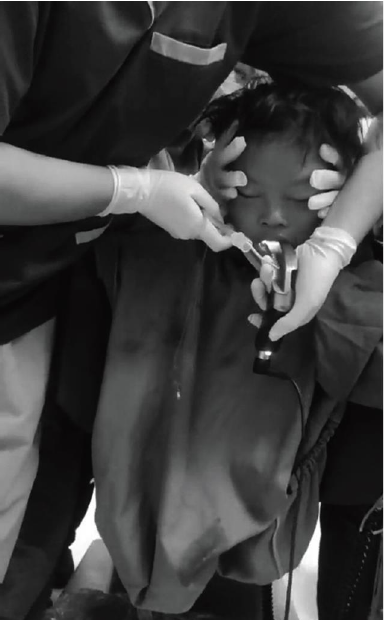
Figure 4: Laryngoscopy is performed from the side of the